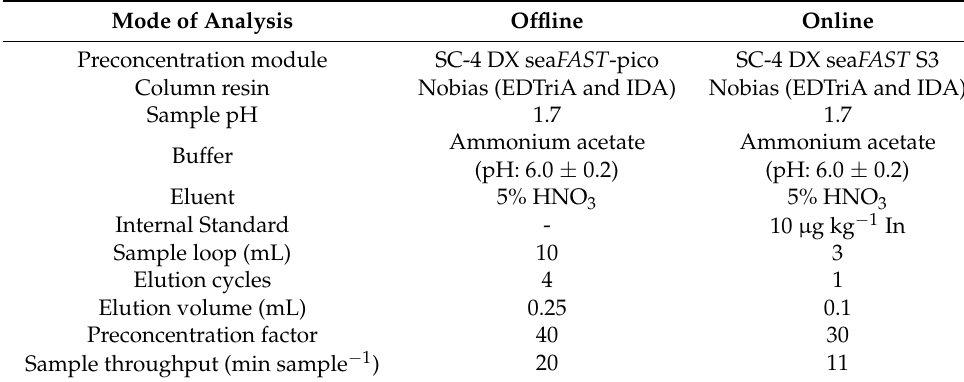
Table 1. Offline and online preconcentration setup.